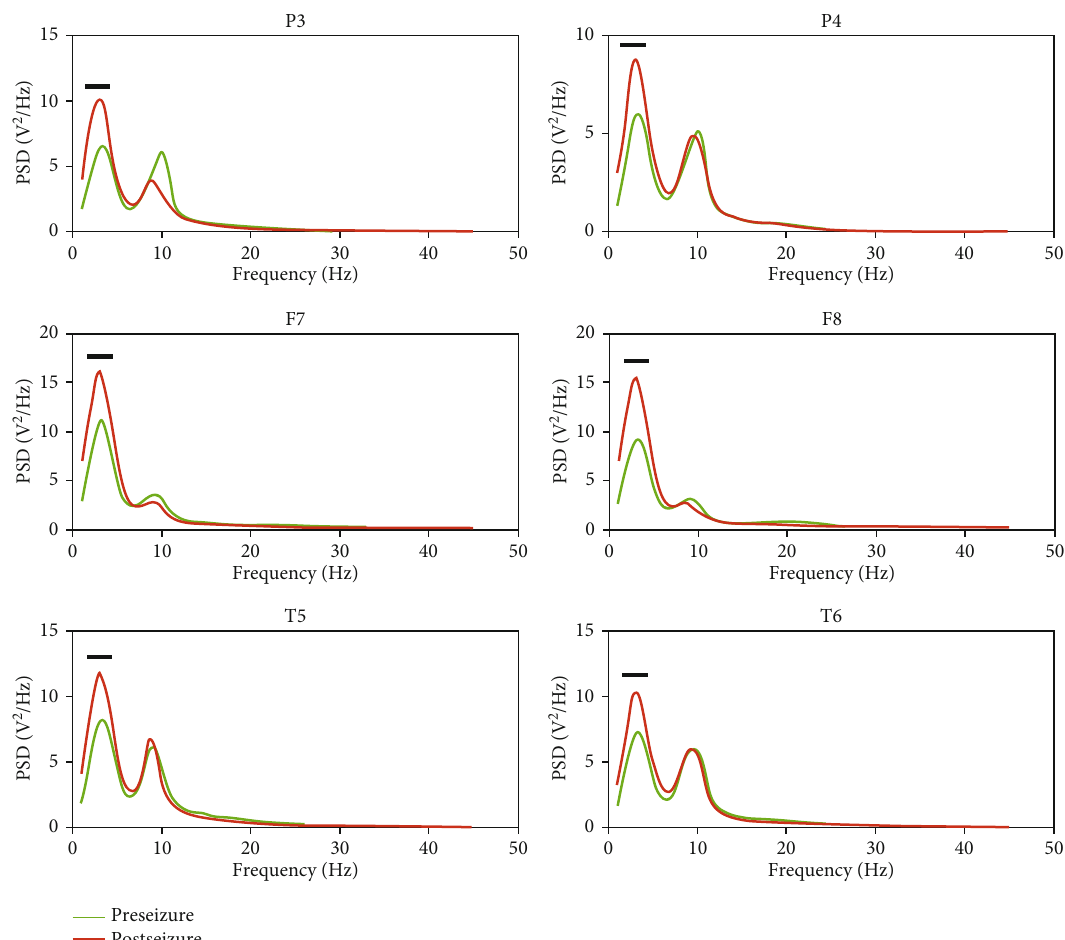
Figure 1: Grand-averaged PSD of the delta band pre- and postseizure. Green and red solid lines denote pre- and postseizure, respectively, and the thick black lines highlight signi fi cant PSD di ff erences ( p < 0 : 05 ) between the two